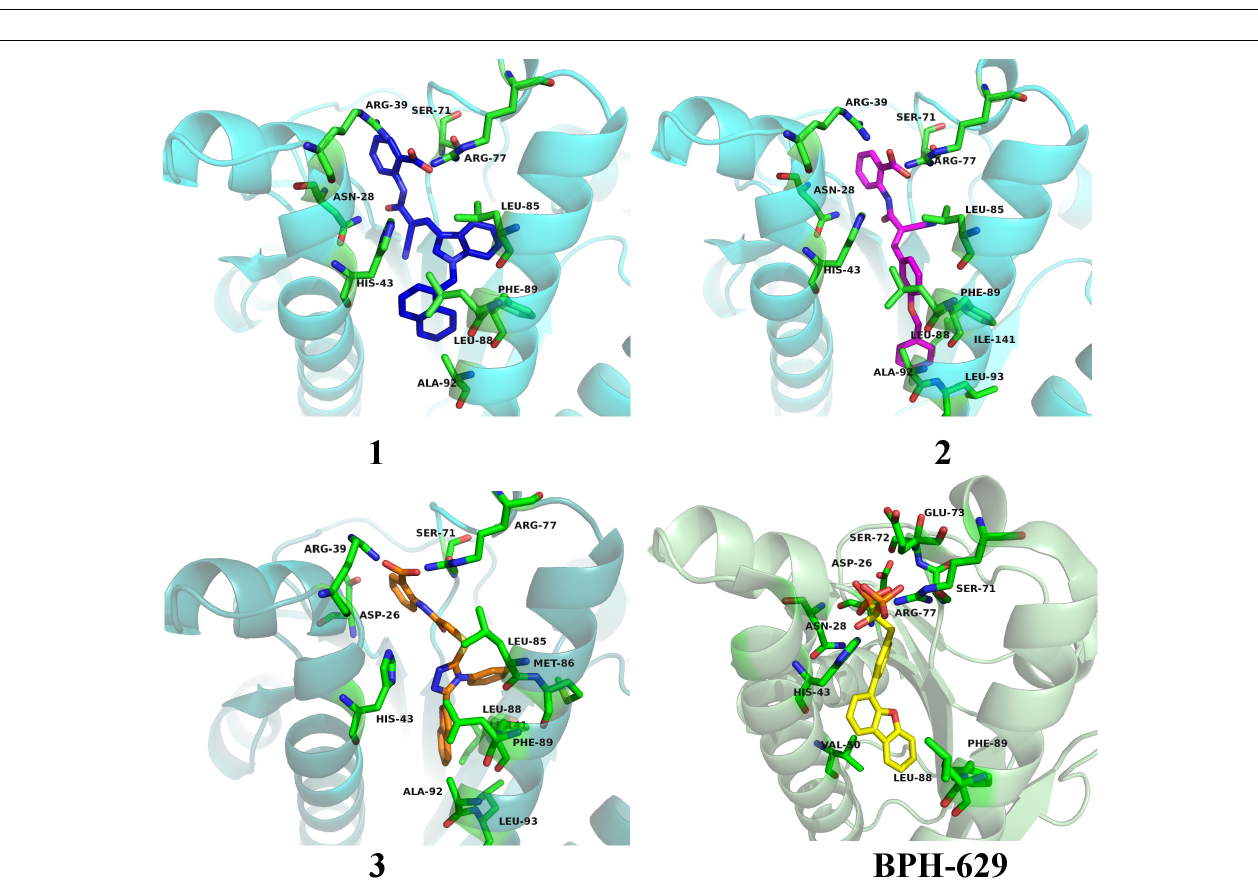
FIGURE 8 | Binding modes of compounds 1–3 (presented in blue, magenta and orange colored stick models, respectively) in UppS active site (PDB ID: 2E98). Co-crystallised ligand BPH-629 is shown as yellow stick model. Protein is depicted as blue or green colored ribbon model with amino acid residues around ligands presented gren colored stick